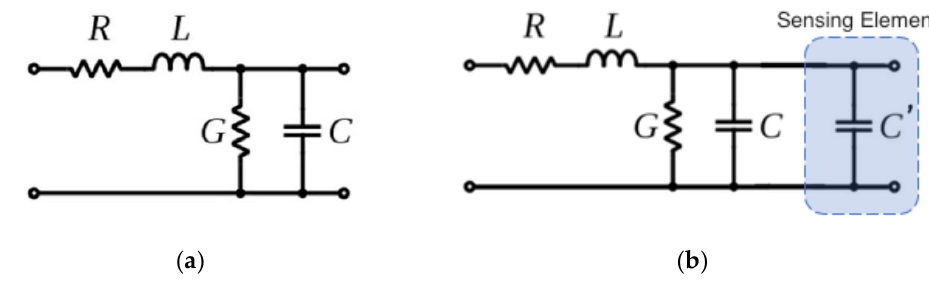
Figure 2. The equivalent circuit models of ( a ) a unit length transmission line and ( b ) a transmission line connected to the capacitive tilt sensor are illustrated.